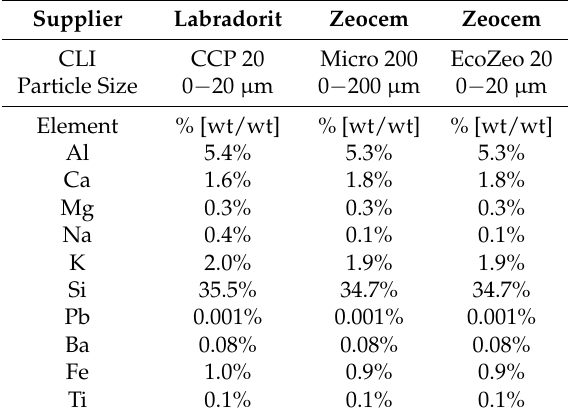
Table 2. Relative atomic percentages (weight/weight) of examined